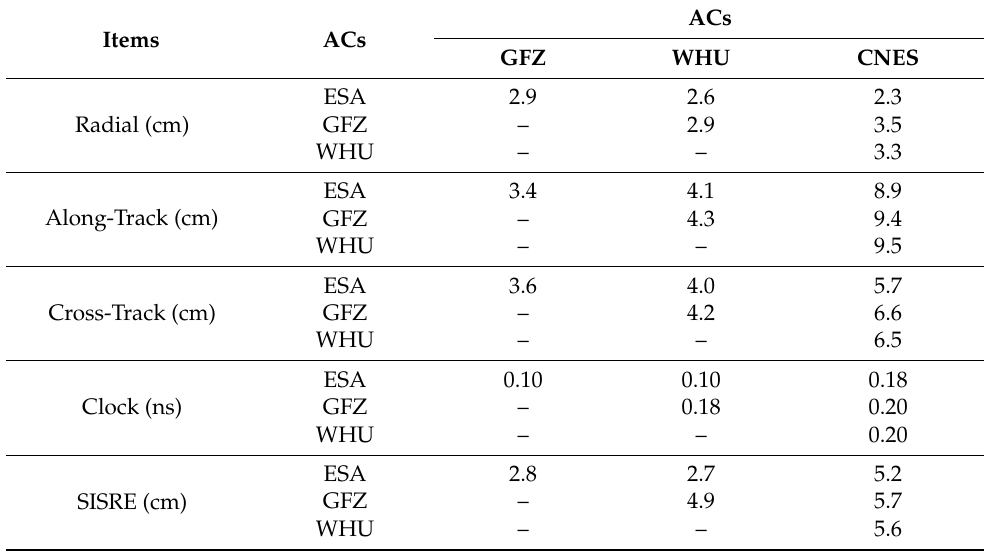
Table 3. RMSs of epoch-wise differences of precise satellite orbit and clock corrections among different ACs as well as SISRE statistics for GLONASS